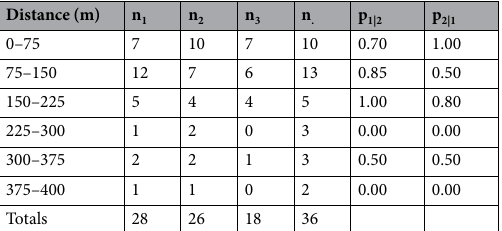
across the PTF (including management area 5 and trawler-associated dolphins) of 2,274 (95% CI = 1,247–4,214) dolphins.